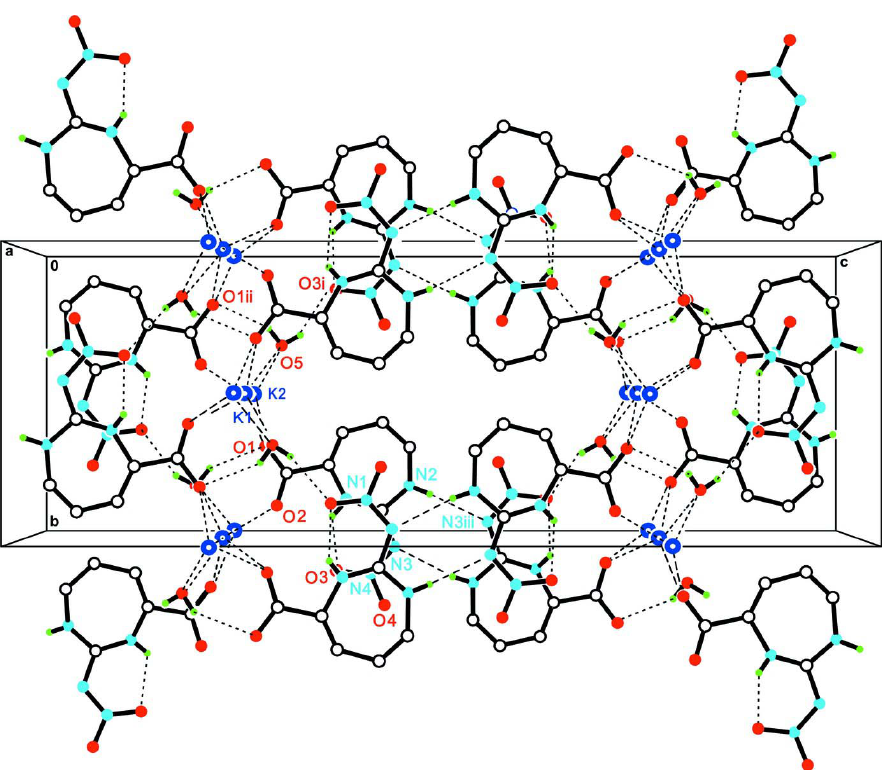
Packing of the molecules. For clarity, only the donors in the original molecule and their corresponding acceptors are labelled. Symmetry codes are: (i) x , y - 1, z ; (ii)- x + 1/2, y - 1/2, - z + 1/2; (iii) x , 2 - y , 1 - z . Dashed lines indicate hydrogen bonds. H atoms not involved in hydrogen bonding have been